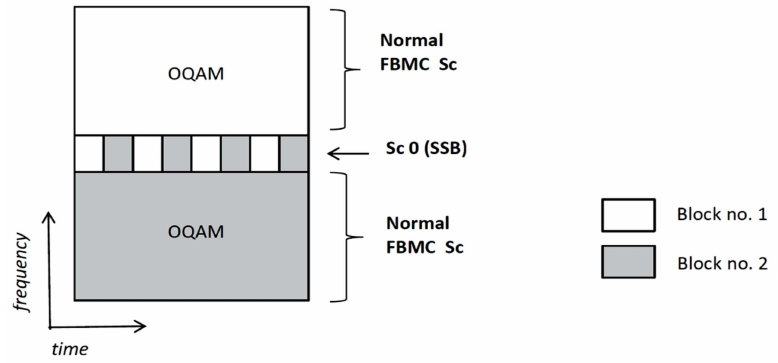
Figure 14. The resource mapping scheme.